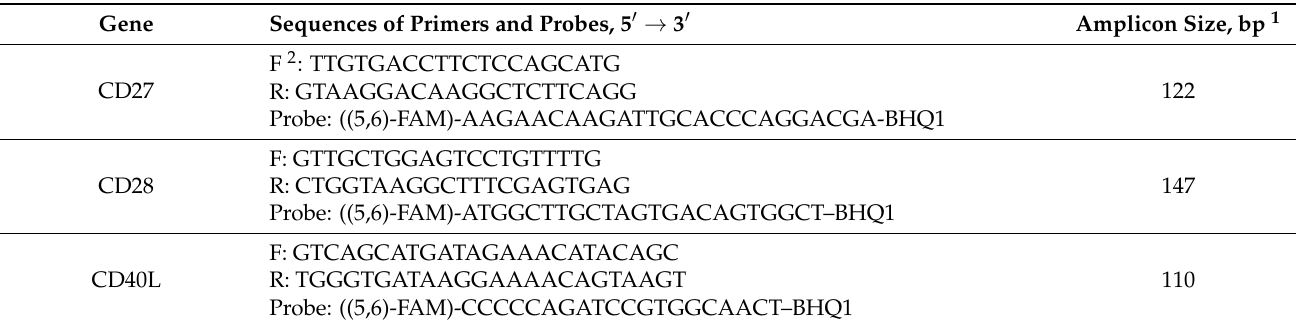
Table 1. List of primers and probes used in the